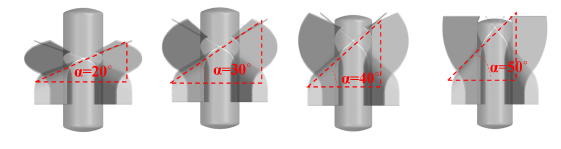
Figure 4. Schematic of different vane bending angles.